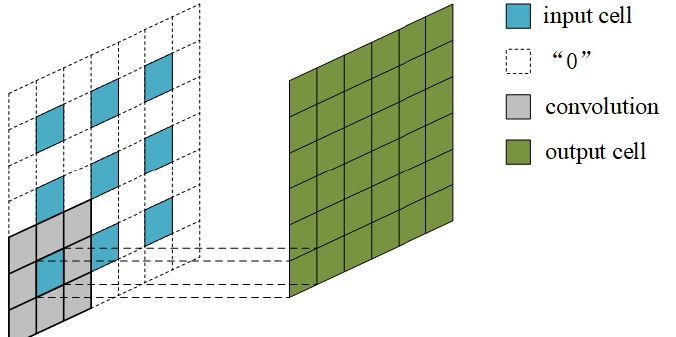
Figure 3. Deconvolution operation with upsampling factor f = 2 and stride = 1. The shape of the input data in the figure is 3 × 3, and the shape of the output data through deconvolution becomes 6 × 6, which achieves 2 ×